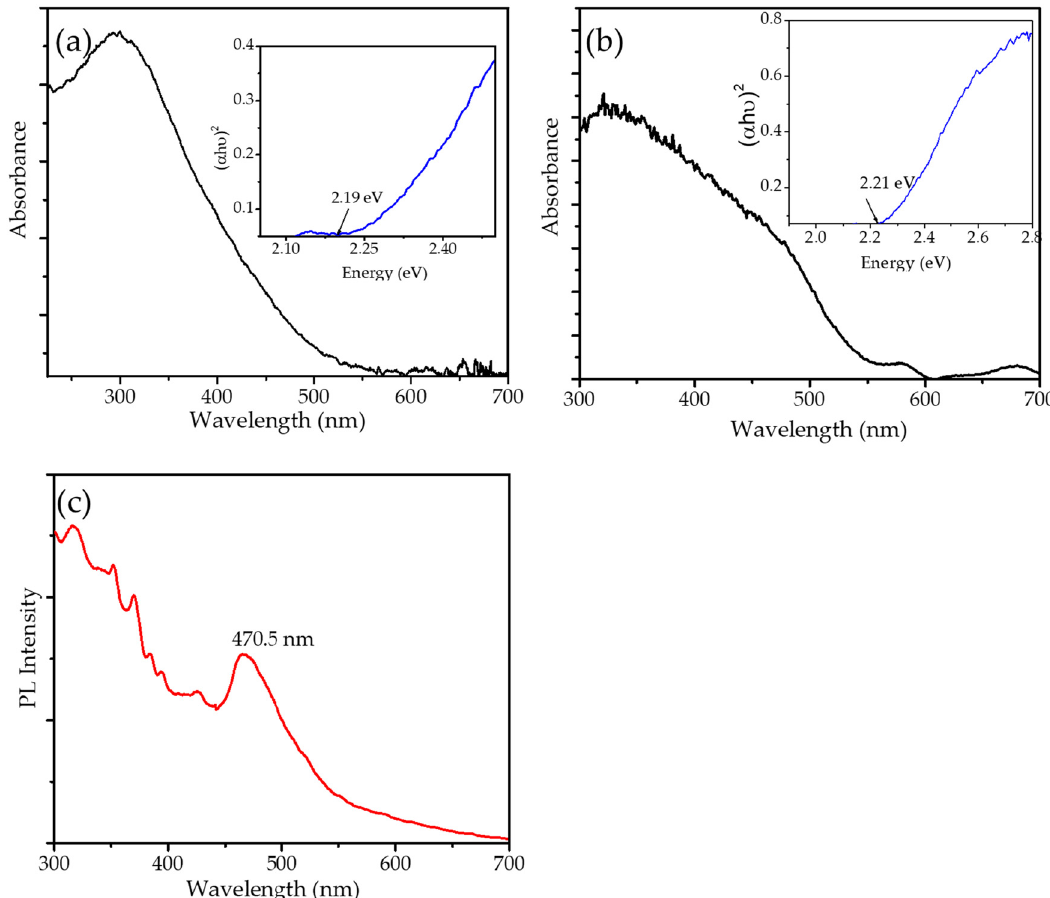
Figure 4: ( a ) UV - DRS spectrum of Fe 3 O 4 ; ( b ) UV - DRS spectrum of Fe 3 O 4 @SiO 2 ; and ( c ) PL spectrum of Fe 3 O 4 @SiO 2